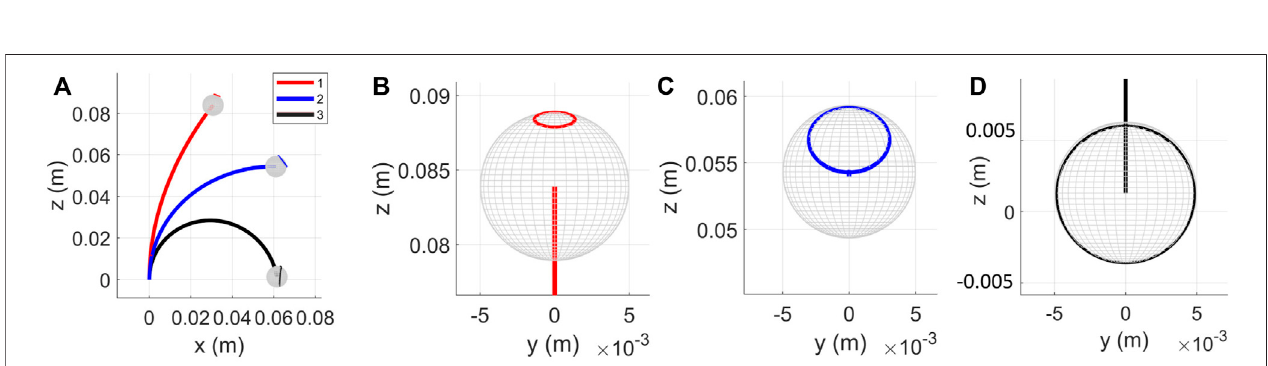
FIGURE10| PositionredundancyevaluatedforthreepositionsforaFASsegment. (A) Threecon fi gurationsconsideredforevaluation.Theservicesphereisplotted for con fi guration one in red (B) , two in blue (C) , and three in black (D) . Friction coef fi cient is assumed to be zero.